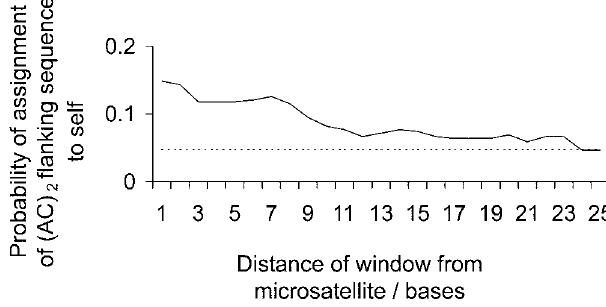
Figure 10. Relationship between the Probability of Assigning (AC) 2 Microsatellite Flanking Sequences to Self and Proximity to the AC Microsatellite Solid line shows the probability of assignment back to self. Analysis is restricted to (AC) 2 flanking sequences and is based on an assignment window 25 nucleotides wide on each side of the microsatellite. Dotted line indicates assignment probability expected of random DNA sequences. DOI: